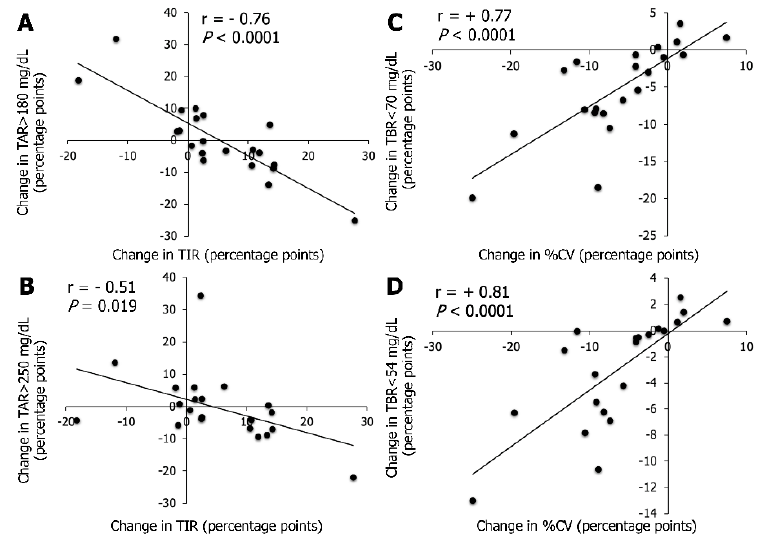
Figure 4. Linear association between changes obtained after switching from FSL1 to DG4 at M12 for TIR with TAR > 180 mg/dL ( A ) or with TAR > 250 mg/dL ( B ), and for glucose %CV with TBR < 70 mg/dL ( C ) or with TBR < 54 mg/dL ( D ). Changes were calculated from DG4 12-month parameters − FSL1 last 3-month parameters (values at M12 − values at M0) in 21 T1D patients and are expressed as percentage points. Correlation analysis was performed using Spearman’s rank correlation coefficient denoted by “r” for rho on the figure ( p < 0.05). Equation of the line for A or B: change in TAR > 180 mg/dL= − 1.02 × [change in TIR] + 5.43; change in TAR > 250 mg/dL = − 0.52 × [change in TIR] + 2.20. Equations of the lines for C or D: change in TBR < 70 mg/dL = 0.65 × [change in %CV] − 1.16; change in TBR < 54 mg/dL = 0.43 × [change in %CV] − 0.24. Abbreviations: %CV, glucose coefficient of variability; DG4, Dexcom platinum G4; FSL1, FreeStyle Libre version 1; T1D, type 1 diabetes; TBR, time-below-range; TIR, time-in-range; TAR, time-above-range. No association was found between the number of scan/d with FSL1 at M0 and the evolution of metrics with DG4 over 12 months of follow-up.